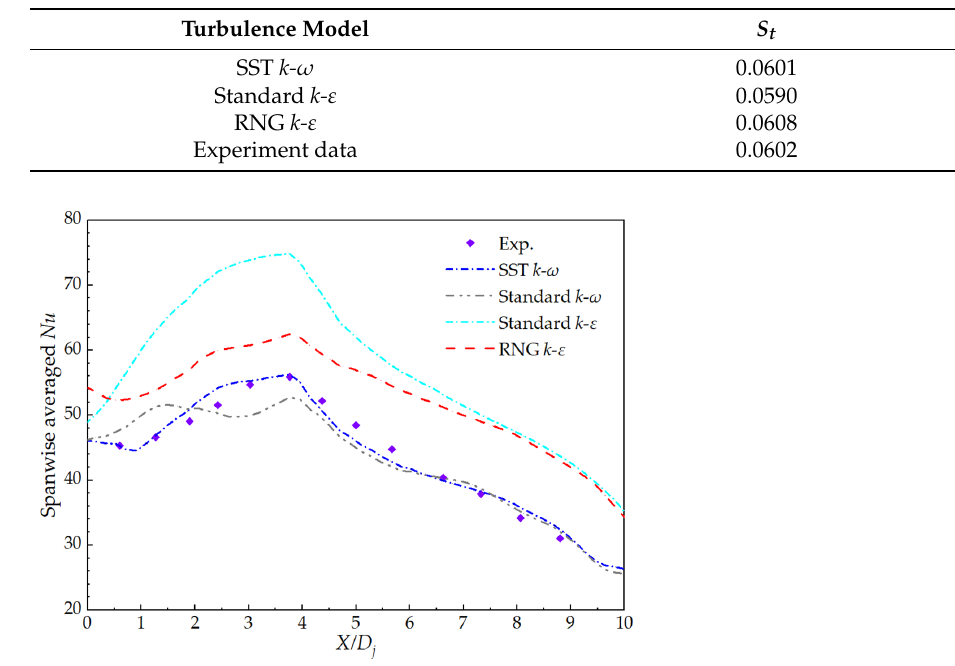
Table 2. Aerodynamic comparison between experimental data [12] and different turbulence models for sweeping jet at Re = 35,200, H/D = 5.